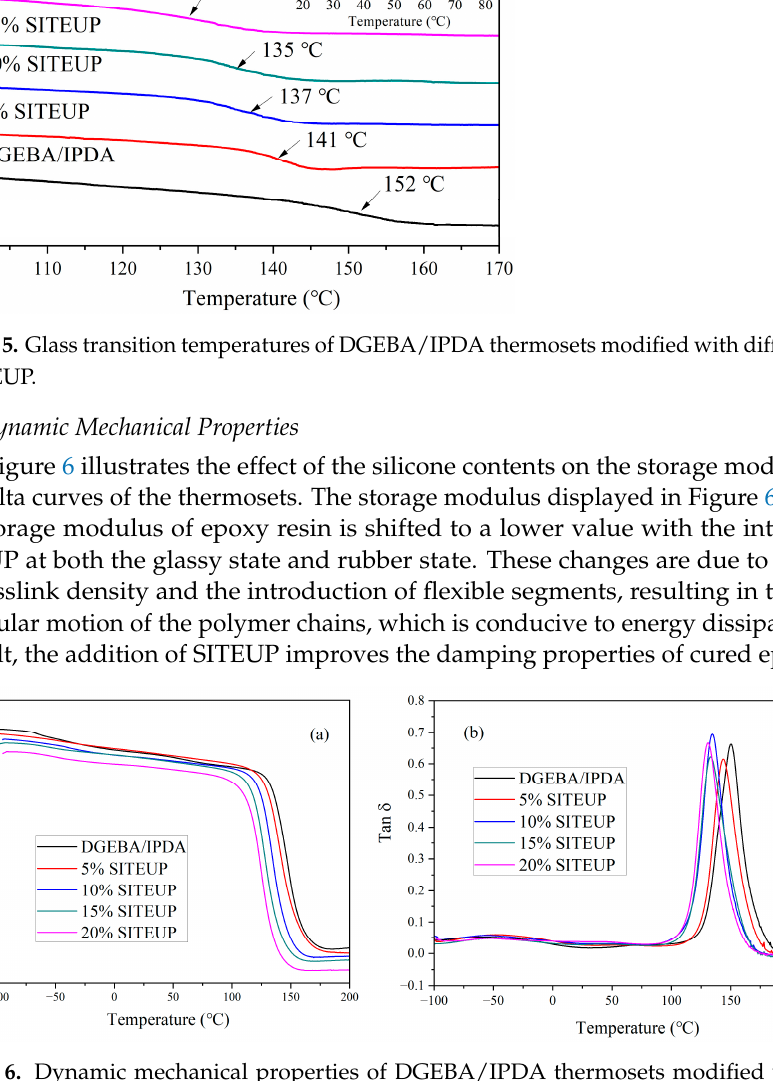
Figure 6. Dynamic mechanical properties of DGEBA/IPDA thermosets modified with different contents of SITEUP. ( a ) Storage modulus and ( b ) Tan δ against temperature.